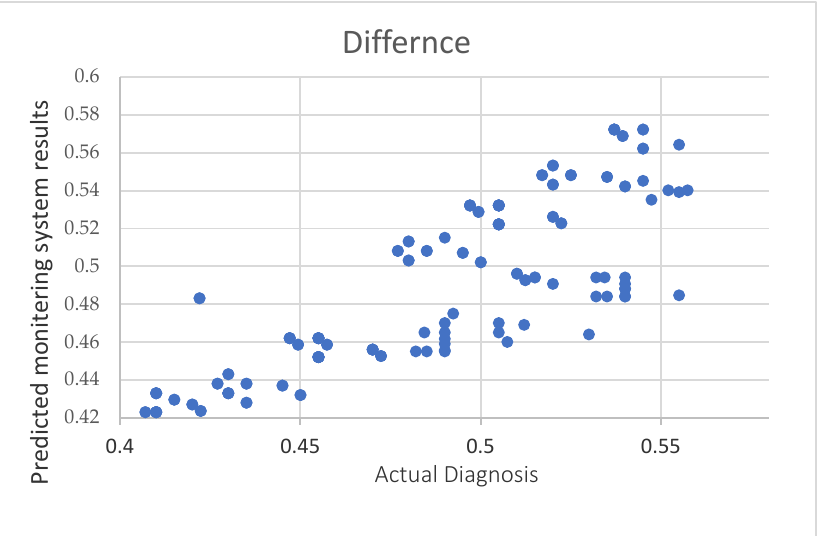
Figure 7. The correlation of the real ratio of health risk incidence in cases from a medical diagnosis Figure 4. Example of fall images in the datasets SV-S2017. versus the prediction of risk incidence from the proposed monitoring system.